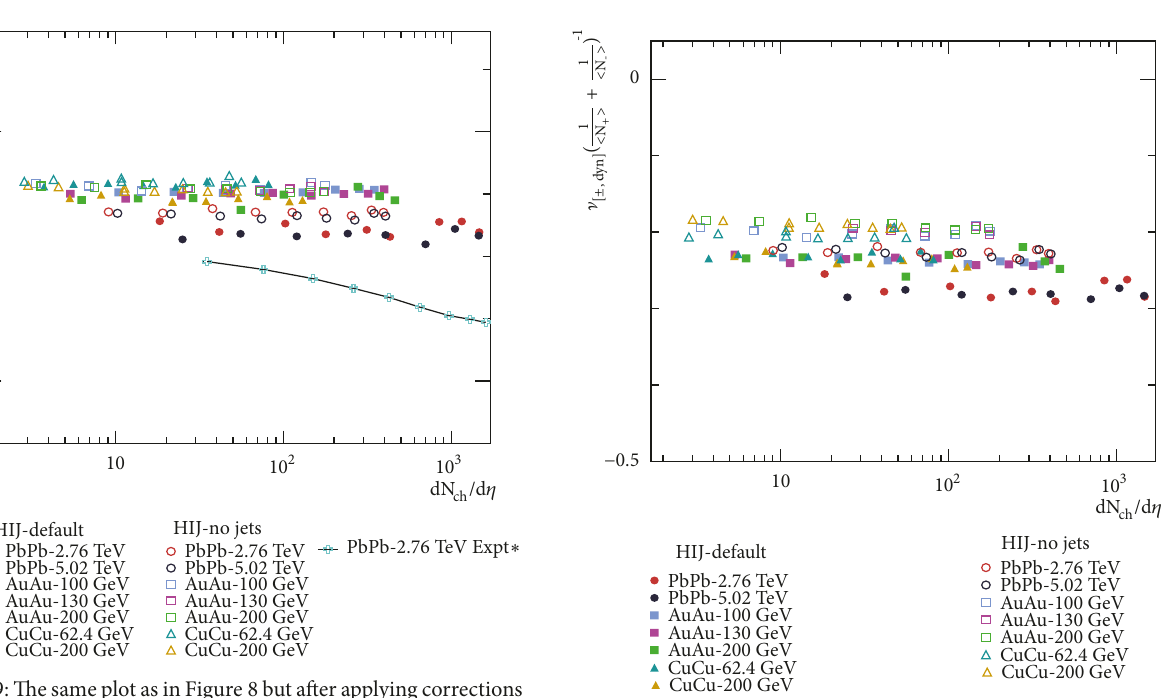
⟩ + 1/⟨𝑁 ⟩) scaling of net charge fluctuations + − at different energies for the two sets of HIJING